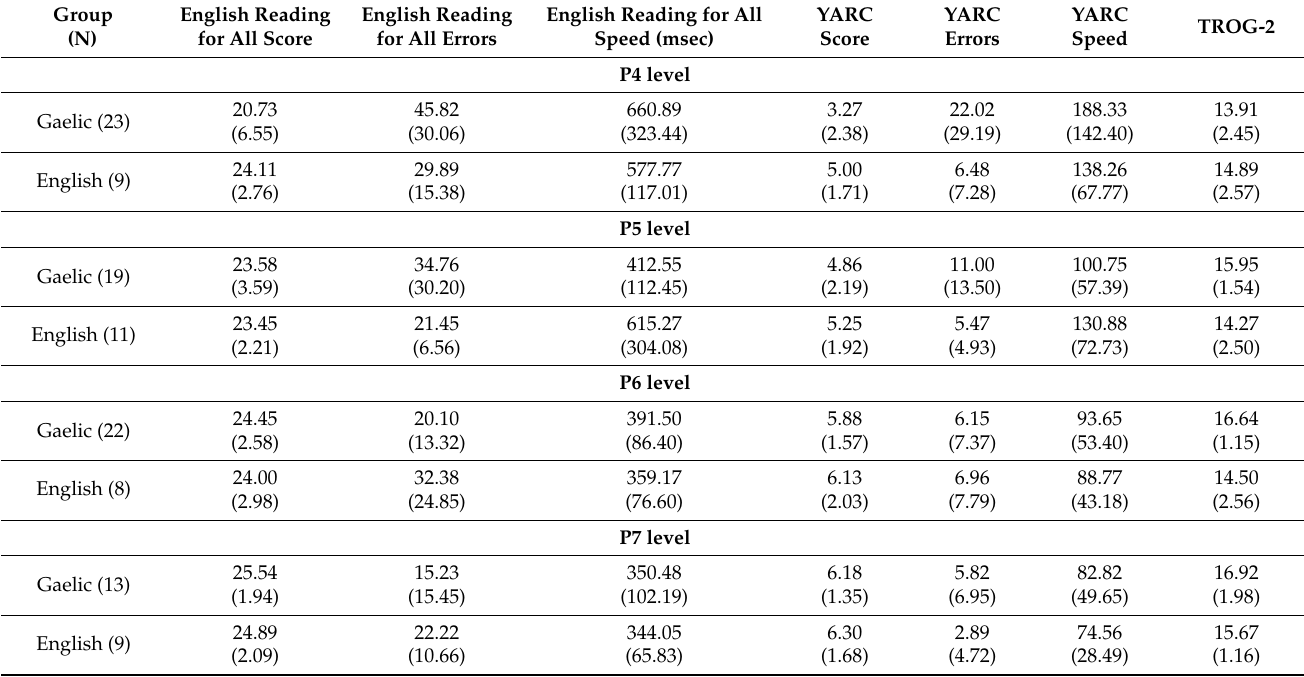
Table 2. Raw data on the English Reading for All test, York Assessment of Reading for Comprehension (YARC) and Test for Reception of Grammar-2 (TROG-2) across age and linguistic groups. All cells report means and standard deviation. Group English Reading (N) for All